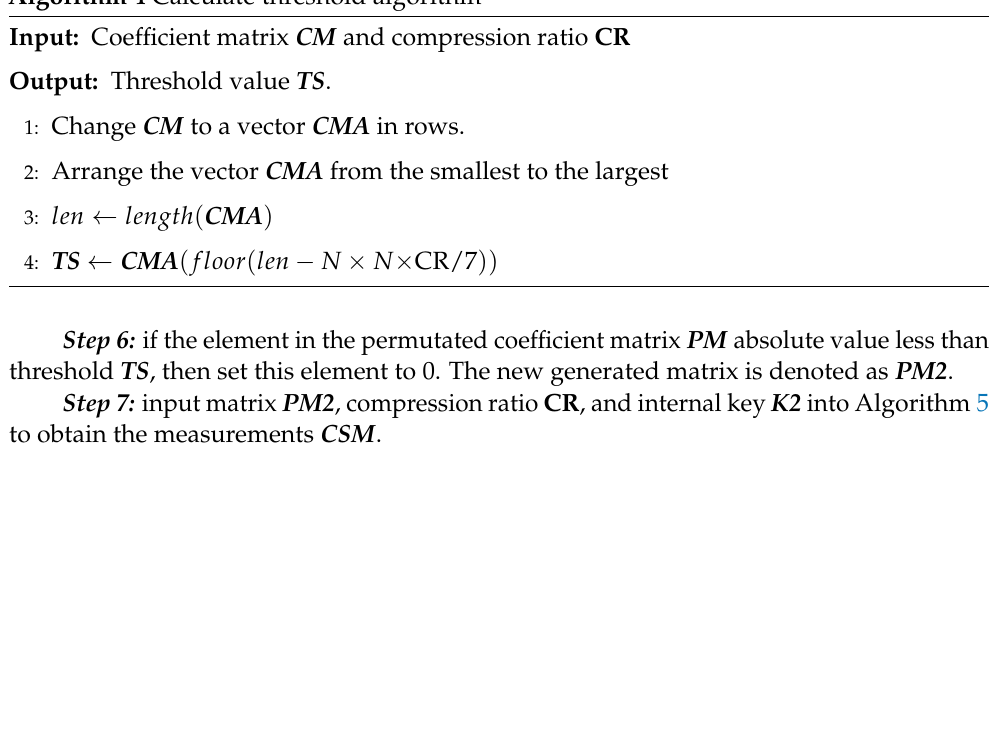
Algorithm 4 Calculate threshold